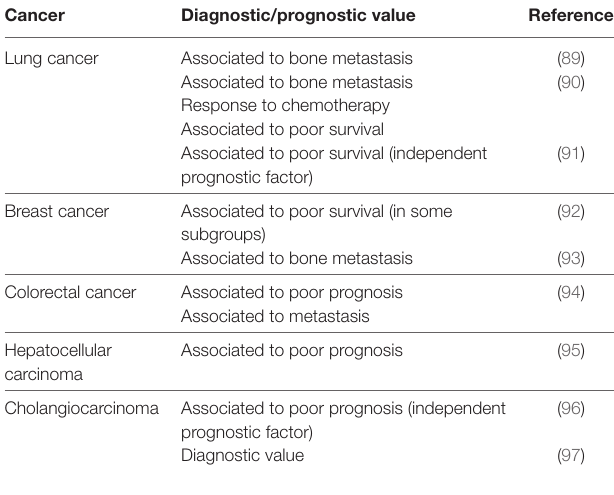
TAbLe 2 | Serum periostin levels as a prognostic